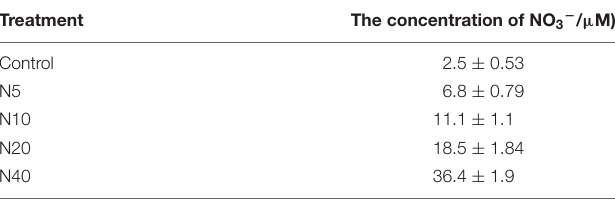
TABLE 1 | Nitrate concentration of each